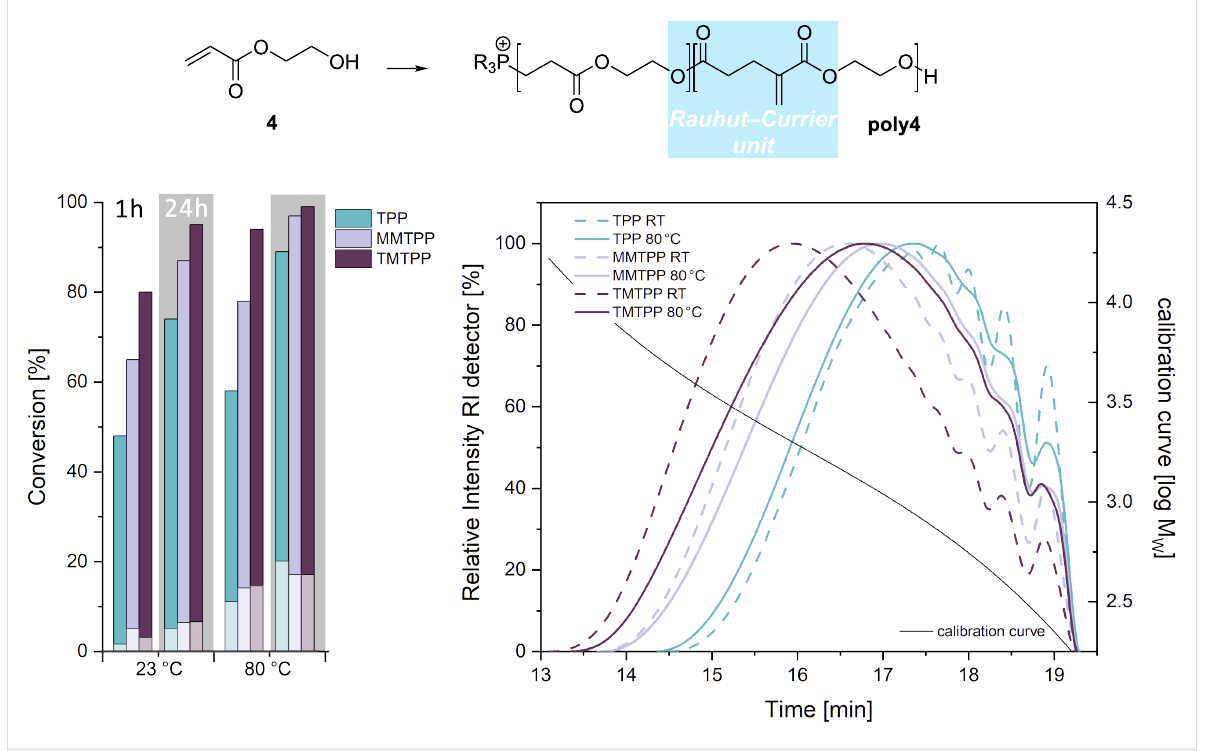
Figure 2: Left: double-bond conversion of the polymerization of 4 initiated by 5 mol % TPP, MMTPP or TMTPP after 1 h at room temperature (23 °C) and at 80 °C as well as after 24 h at 23 °C and at 80 °C; light sections of the bars represent the share of Rauhut–Currier repeat units; right: size exclusion chromatograms (in THF, relative to poly(styrene) standards) of poly4 prepared with 5 mol % TPP, MMTPP or TMTPP using a reaction time of 24 h and a reaction temperature of 23 °C (dashed lines) or 80 °C (full